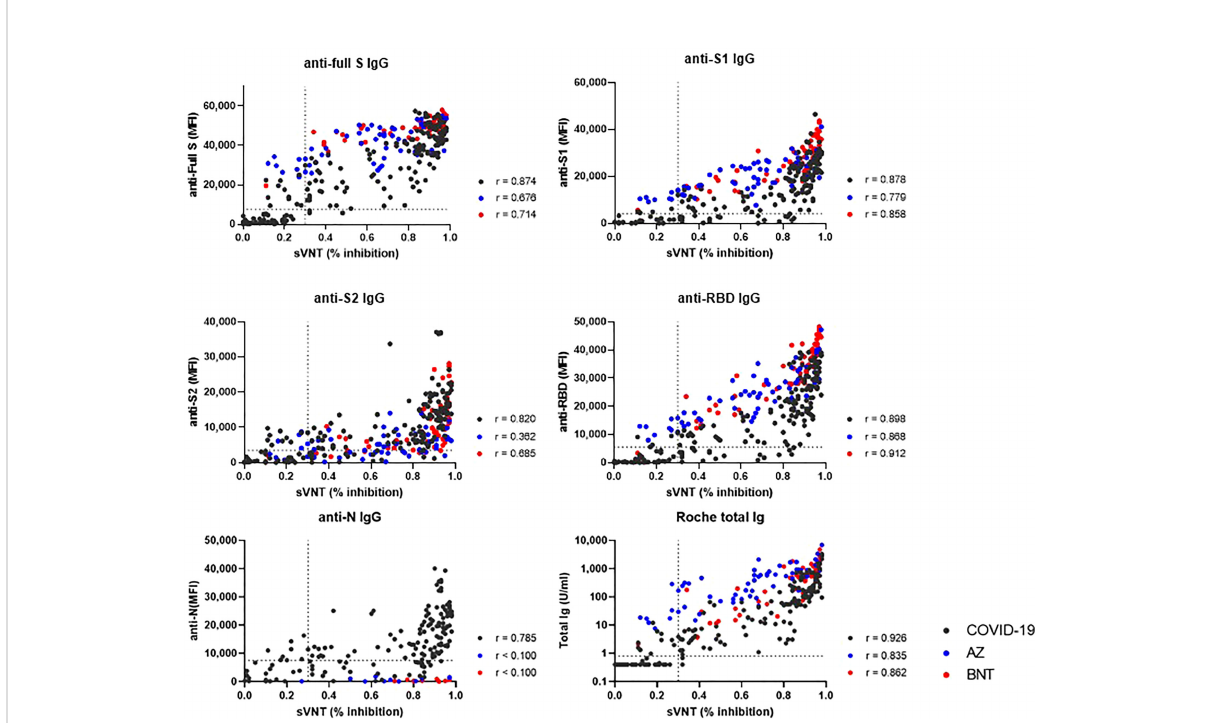
FIGURE 7 Correlation between binding antibody levels (anti-full S, S1, S2, RBD and N by luminex-bead assay and anti-S1 RBD total Ig by Roche assay) and neutralization antibody levels by GenScript assay. COVID-19 patients (black dots), AZ vaccine group (blue dots) and BNT vaccine group (red dots) are indicated. Spearman correlation coef fi cients ( r ) and cut-off levels (dotted lines) are